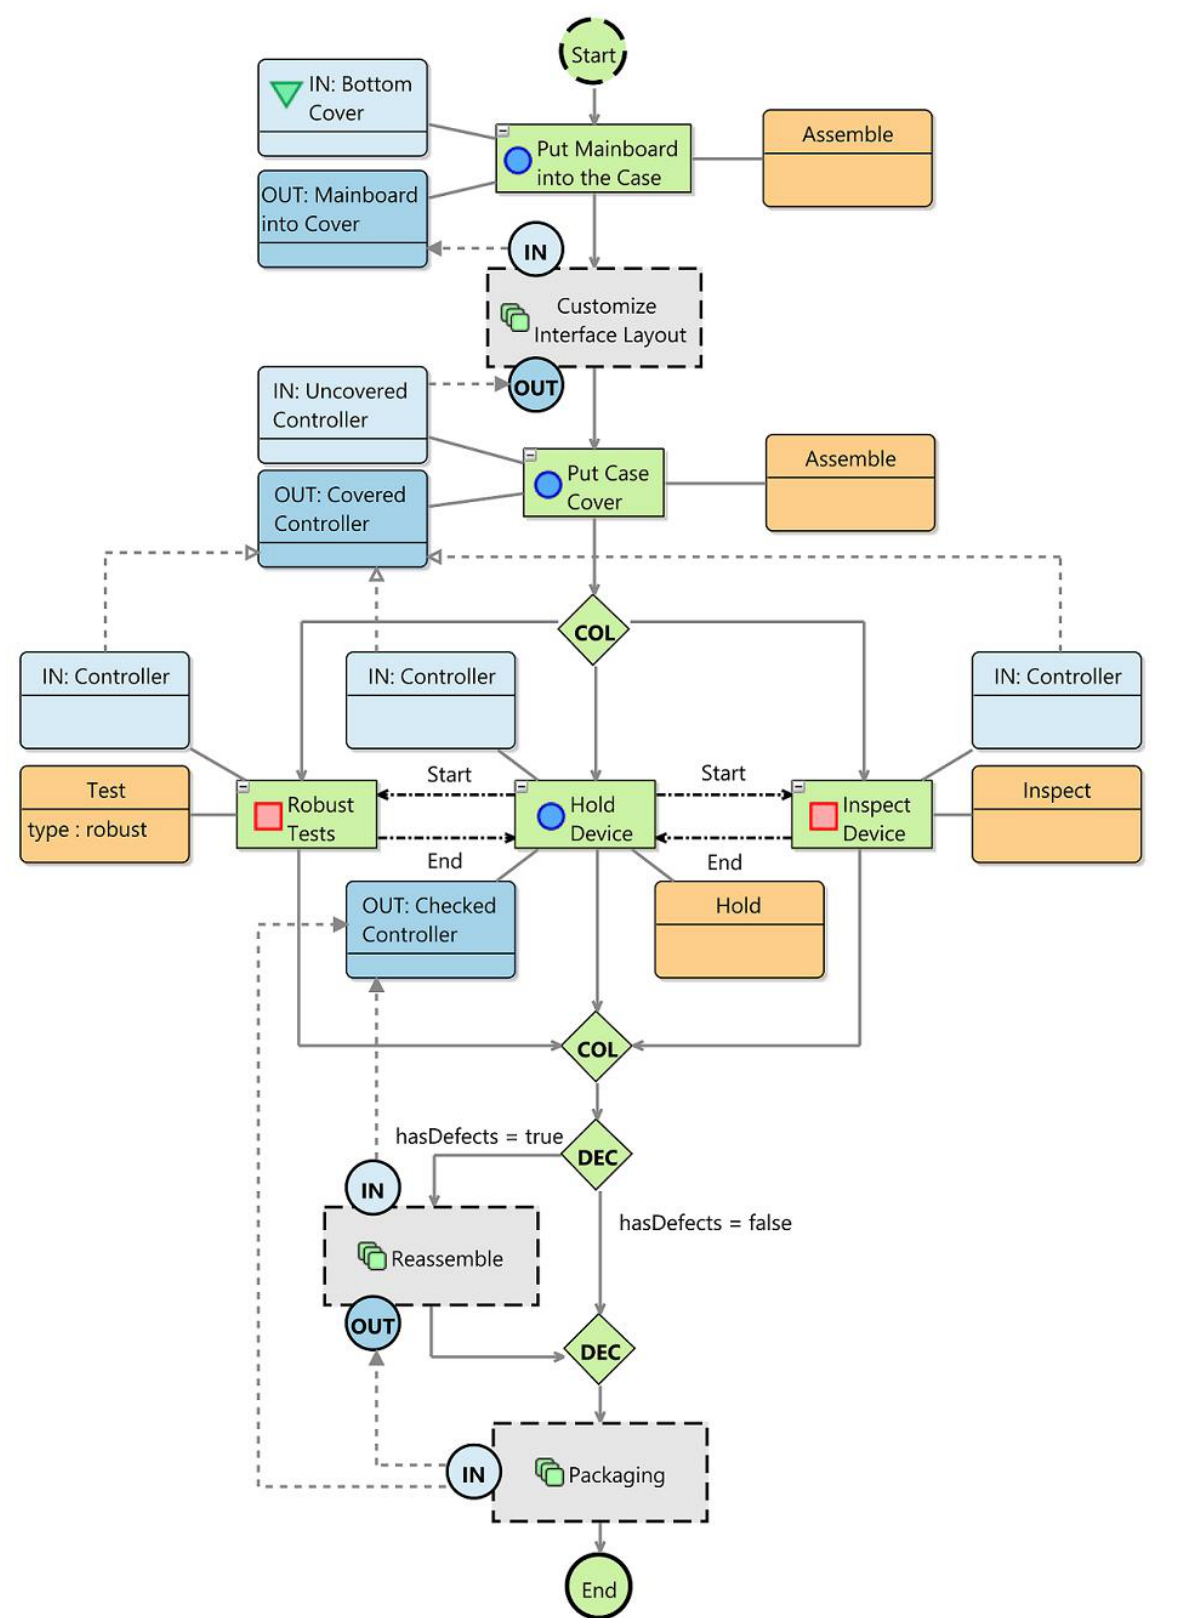
Figure 4. Production process model, created in Process Modeller.